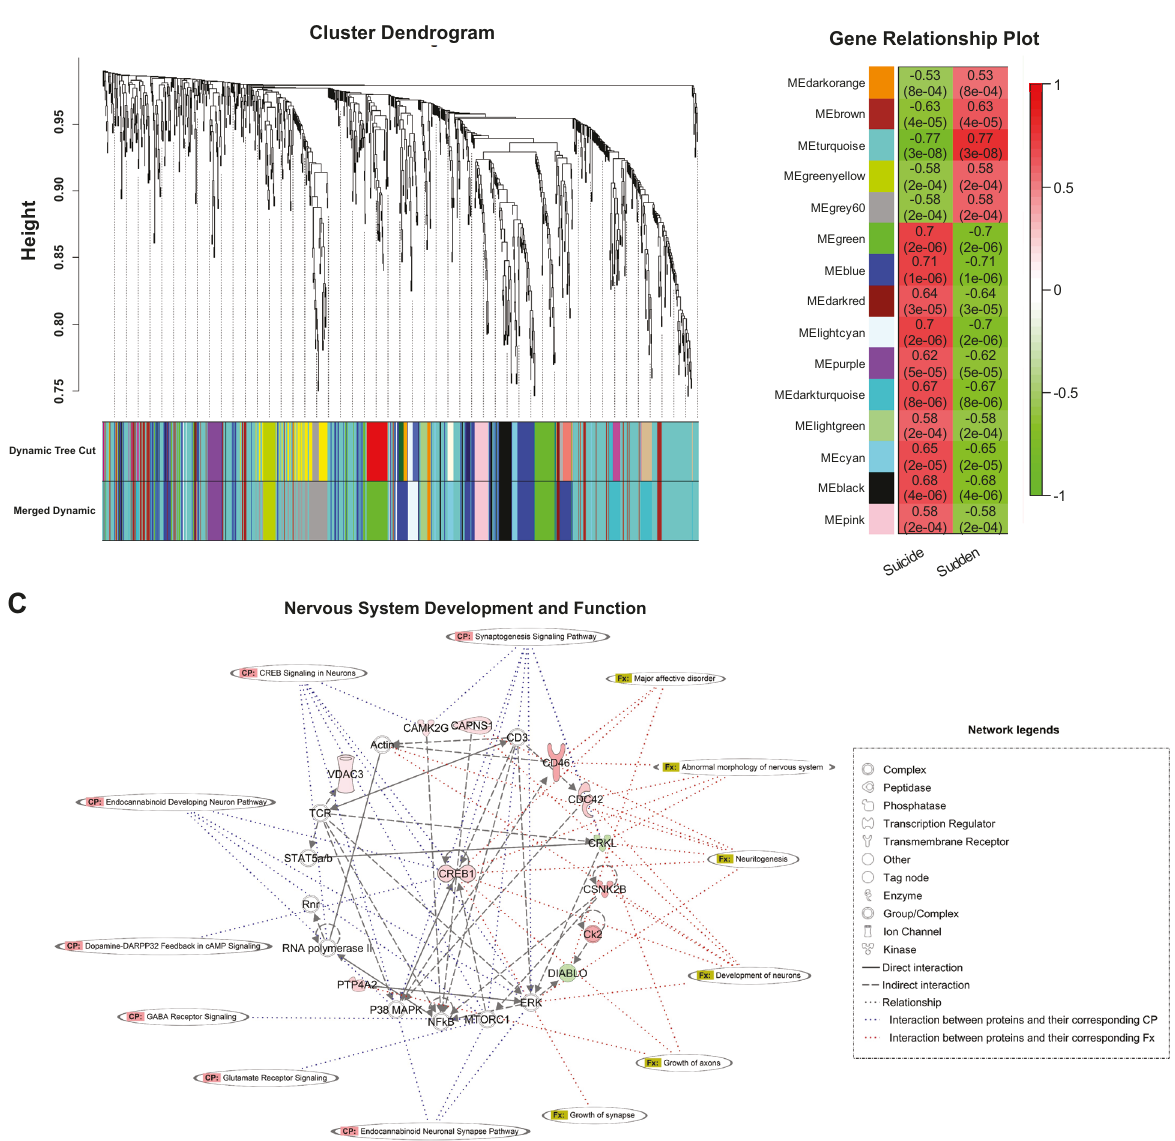
Fig. 3 WGCNA analysis. A Optimal cluster sets obtained by dynamic tree cutting and automatic cluster merging. B Heatmaps showing correlation of module eigengenes. Pearson correlation coef fi cients of each module are shown and differently colored. C The top network of nervous system development and function was identi fi ed using 154 proteins in the blue module, which had the largest correlation with the suicide group. among people who took antipsychotics; and RPS4Y1, S100A10, and MRGPRF were identi fi ed among people who consumed alcohol at the time of death. DISCUSSION In the current study, we identi fi ed protein pro fi les related to suicide and sudden death using postmortem brain tissue. Using bioinformatics tools, we discovered canonical pathways related to suicide completion, such as various neurotransmitter transmission signaling pathways, including endocannabinoid pathways. Through subgroup analyses, we found common proteins between suicide completion and other factors related to suicide such as psychiatric disorders, psychotropic use, and alcohol intake [47, 48].